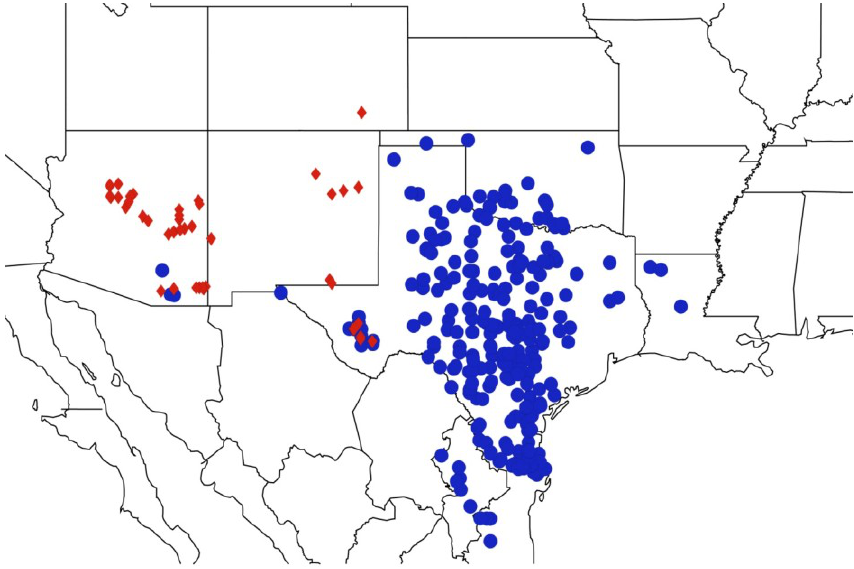
Figure 28. Distribution of Pacarina puella (blue circles) and P. shoemakeri (red